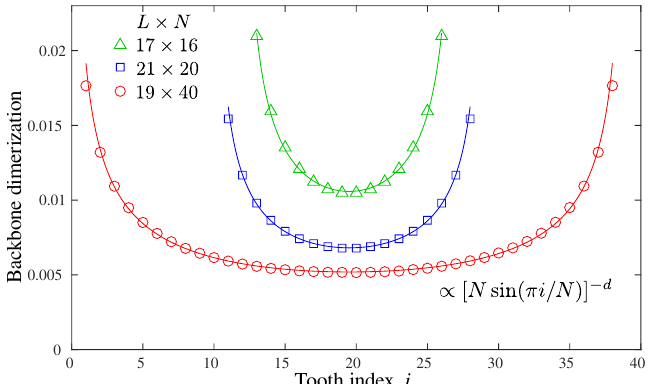
Figure 5: (Color online) Friedel oscillations along the backbone in a comb with an odd number of sites per tooth L . Symbols are our numerical data, lines are fit to the CFT prediction for the envelope. The resulting critical exponents are d ≈ 0.44 for 17 × 16, d ≈ 0.48 for 21 × 20, and d ≈ 0.51 for 19 × 40, which are in good agreement with the CFT prediction d = 1 /